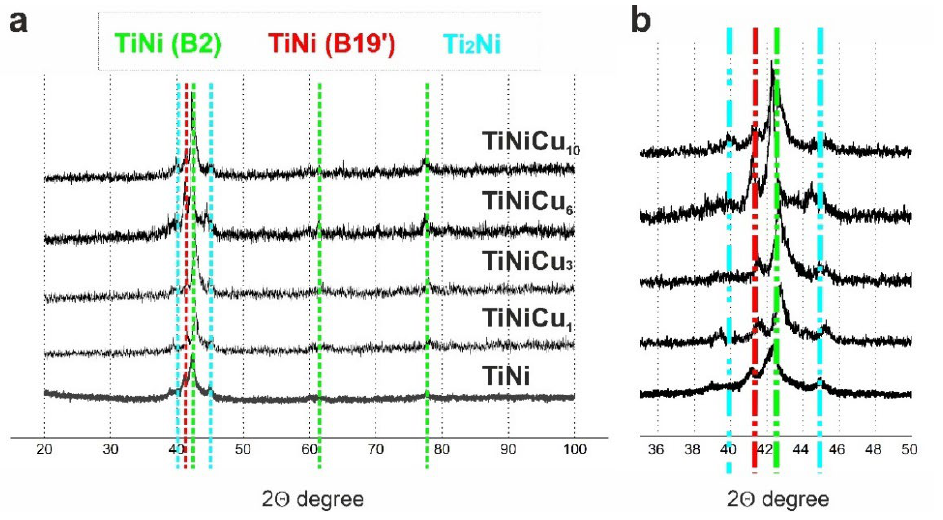
Figure 3. X-ray diffraction (XRD) patterns ( a ) and their enlarged range 38–48° ( b ) for the materials.